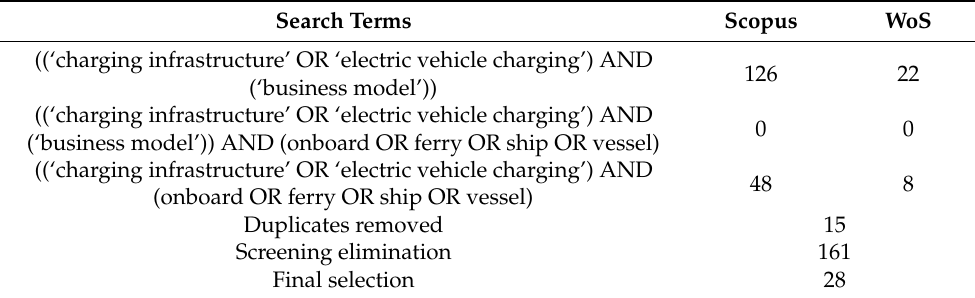
Table 1. Search terms and